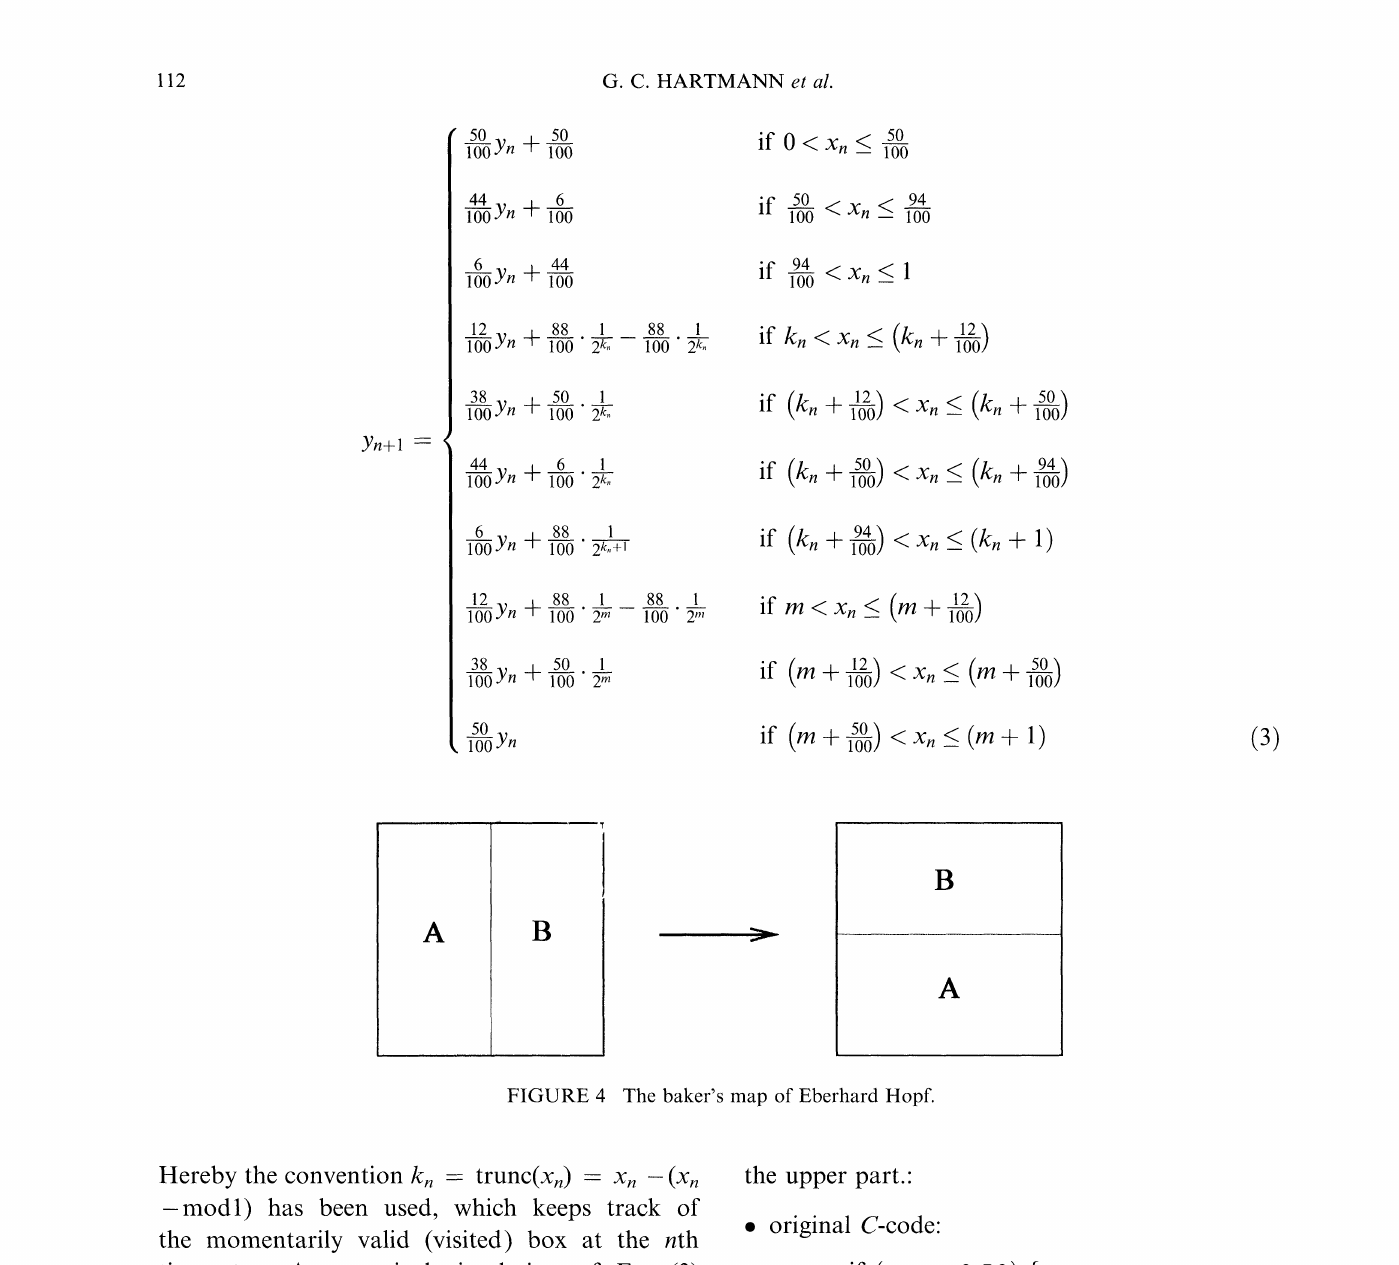
FIGURE 4 The baker’s map of Eberhard